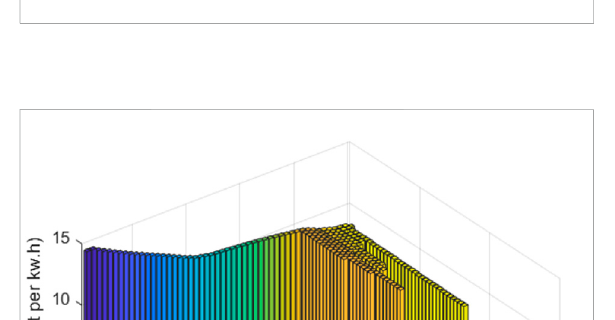
FIGURE 6 Convergence procedure of gas price.